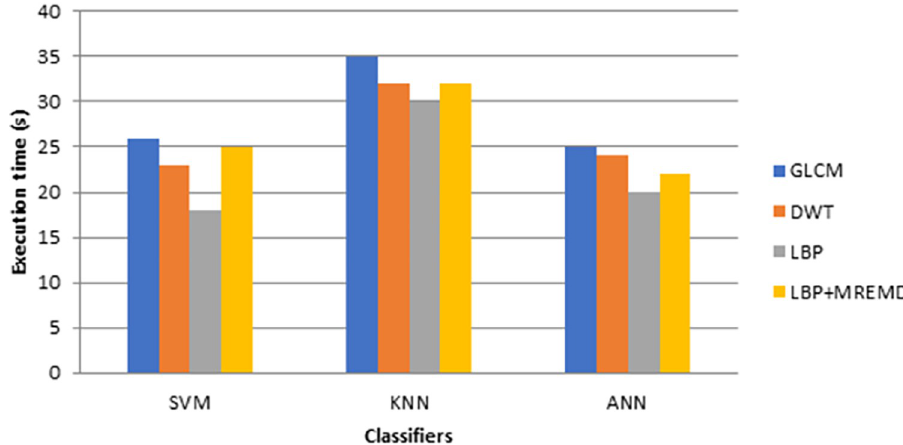
Fig 6. Comparison of execution time for different